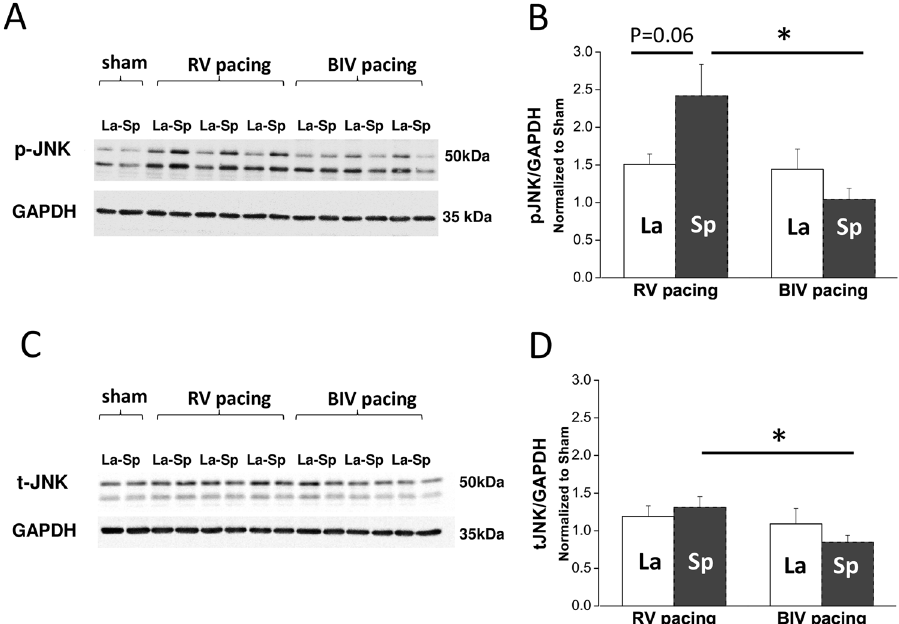
Figure 4. RV tachypacing induces ‘molecular polarization’ of JNK activation between the septum and lateral wall. Biochemical analysis of JNK in rats subjected to either RV tachypacing or BiV tachypacing at a CL of 100 ms for 72 hours. La = lateral wall, Sp = septum. ( A ) Immunoblot demonstrating phospho-JNK (p-JNK) levels relative to GAPDH (loading control). Note the marked increase of p-JNK in the septum of rats exposed to RV tachypacing, which did not occur in response to BiV pacing. Cropped blots are shown. Uncropped blots are presented in Supplementary Fig. 5S. ( B ) Bar graph summarizing the p-JNK densitometry results of 6 individual rats in each pacing mode. ( C ) Immunoblot for total-JNK (t-JNK) relative to GAPDH. Cropped blots are shown. Uncropped blots are presented in Supplementary Fig. 5S. ( D ) Bar graph summarizing the t-JNK densitometry results of 6 individual rats in each pacing mode. Note small but significant effects of RV tachypacing on the total expression of JNK in addition to the more profound effect on phosphorylation